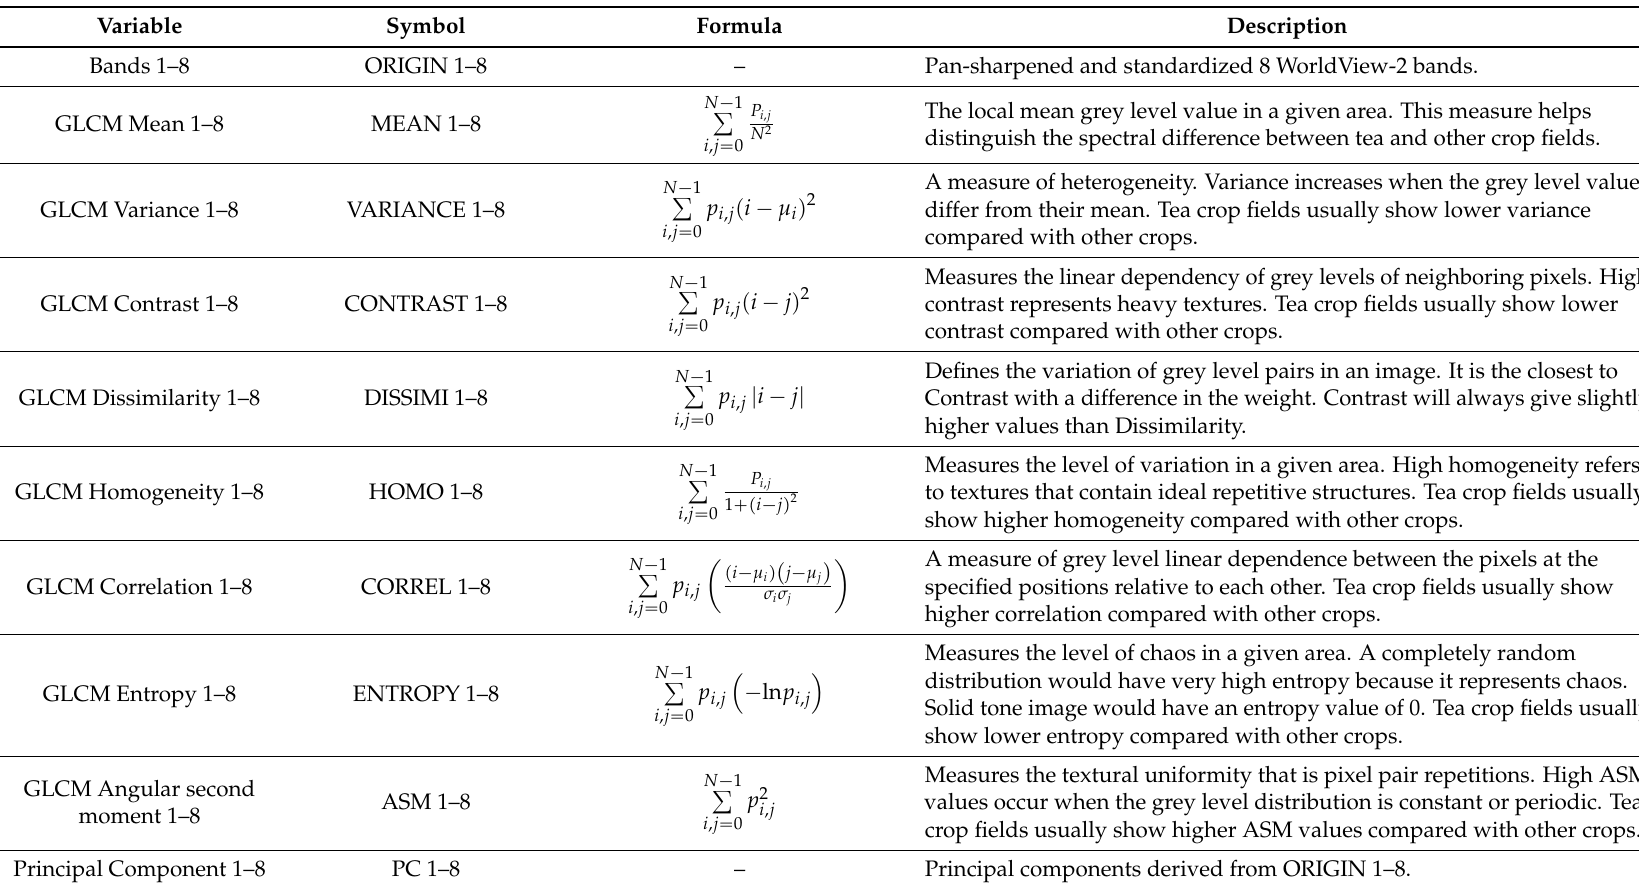
Table 1. Description of the input variables used for the